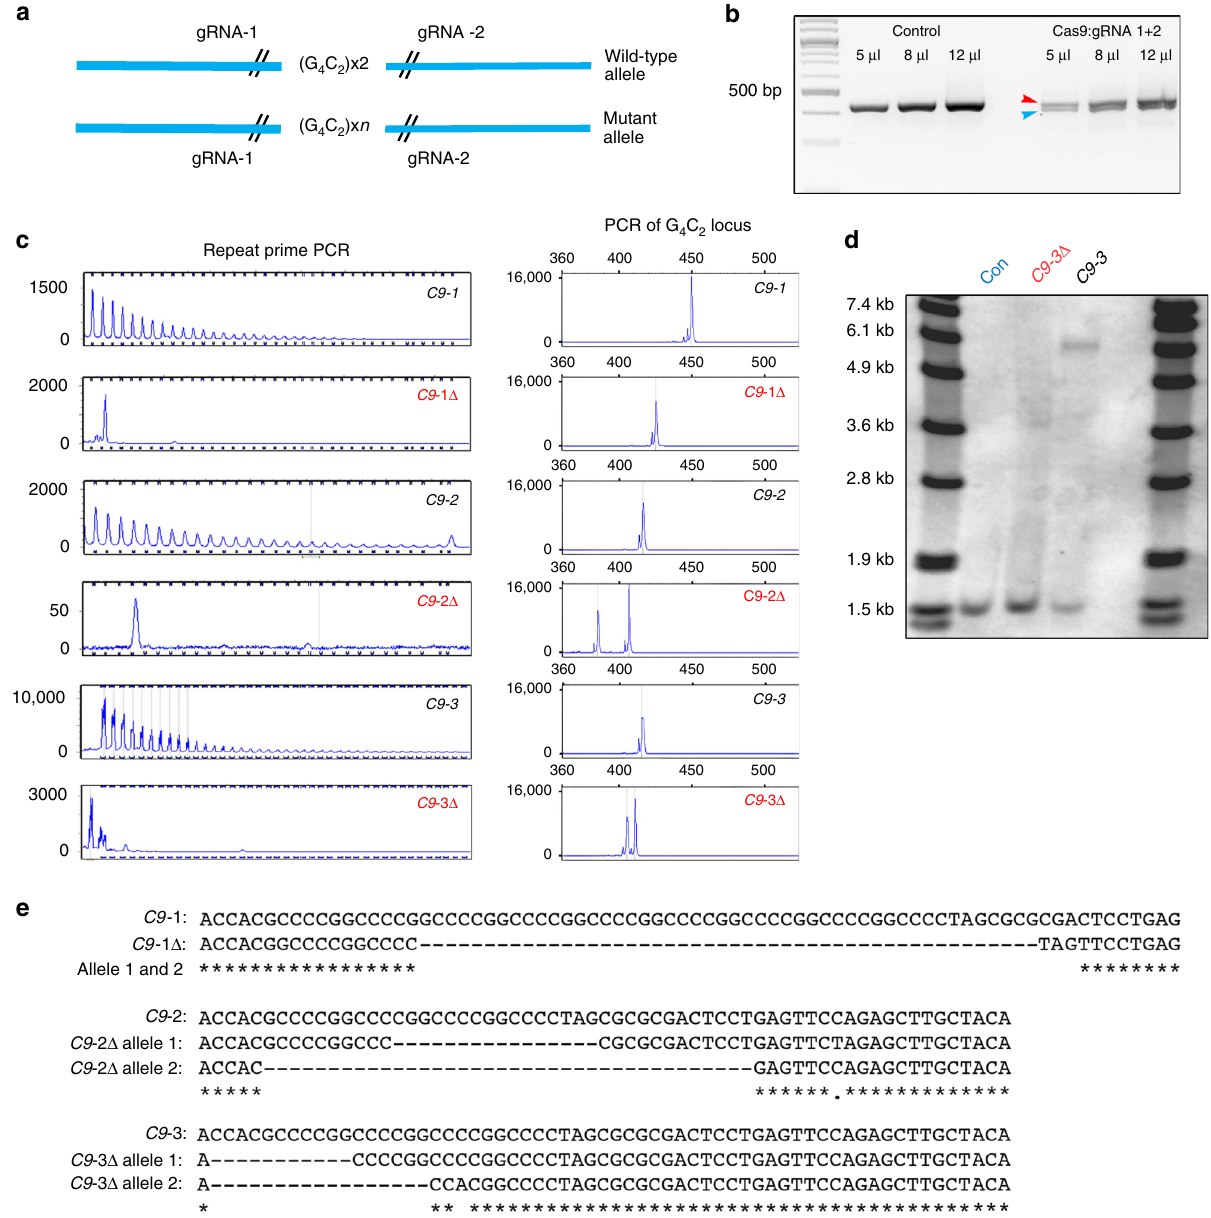
Fig. 1 Excision of the G 4 C 2 repeat expansion. a Strategy for generating C9- Δ from iPSC harboring G 4 C 2 repeat expansion mutation. Two gRNAs were designed fl anking the G 4 C 2 repeats in intron-1 of the C9ORF72 gene to generate a double-strand break (depicted by //). b PCR of the G 4 C 2 locus in HEK- 293 cells transfected with Cas9-gRNA-1 and 2 plasmids generated truncated PCR product (blue arrow) depicting both gRNAs are functional. c Repeat primed PCR and PCR fl anking G 4 C 2 locus showed absence of hexanucleotide repeat expansion in C9- Δ iPSC. d Southern blot analysis of C9ORF72 alleles in control, mutant C9ORF72 , and C9- Δ iPSC lines. e Sanger sequencing of G 4 C 2 locus in C9ORF72 gene-edited lines con fi rmed excision of hexanucleotide repeat expansion in mutant allele. G 4 C 2 repeats in wild-type allele were also excised by CRISPR/Cas9 editing strategy (C9-1: 6 repeats, C9-2: 2